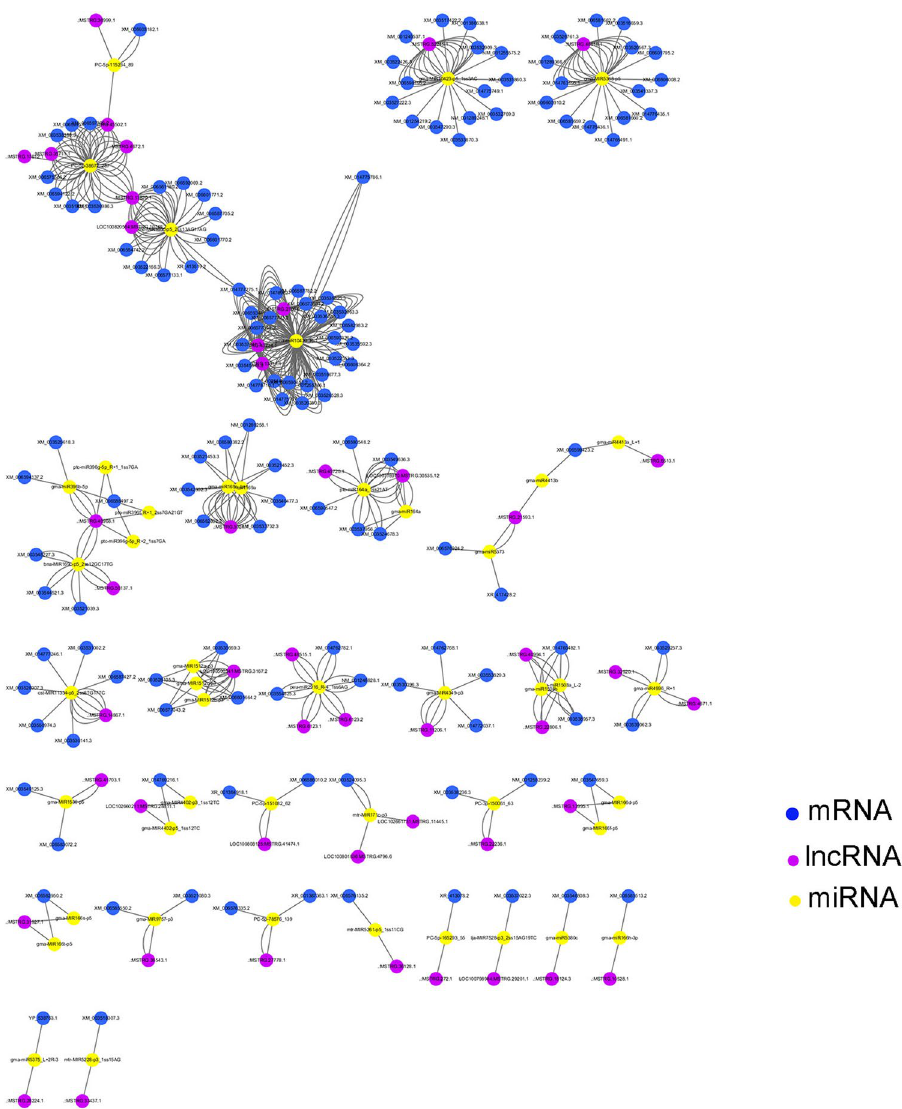
Figure 10. lncRNA-miRNA-mRNA network. The yellow, purple and blue represent miRNAs, lncRNAs and mRNA transcripts, respectively. The Fig. 9 is made from this open software Cytoscape (v3.7.0, http:// www. cytos cape. org/).